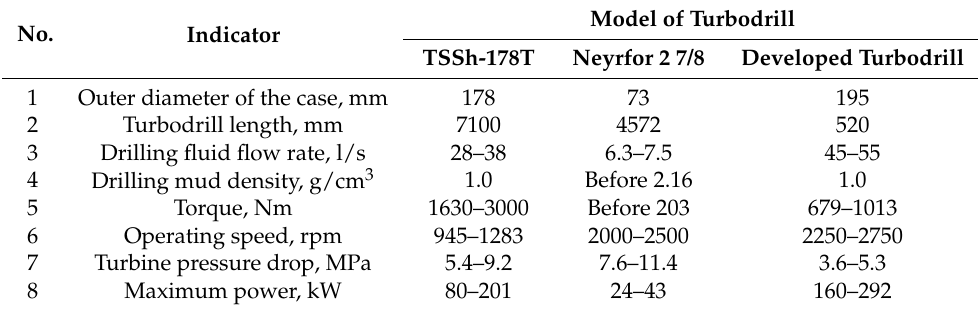
Table 3. Comparison of technical